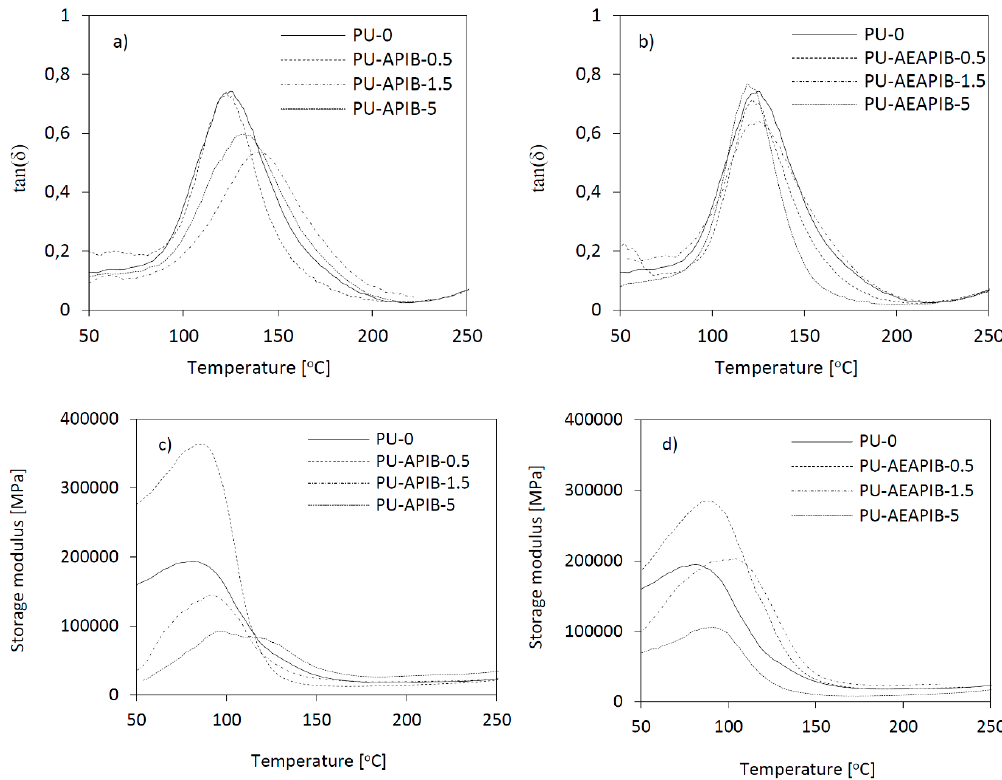
Figure 11. ( a ), ( b ) tan δ and ( c ), ( d ) storage modulus as a function of temperature plotted for RPUFs modified with APIB-POSS and AEAPIB-POSS. with APIB-POSS and